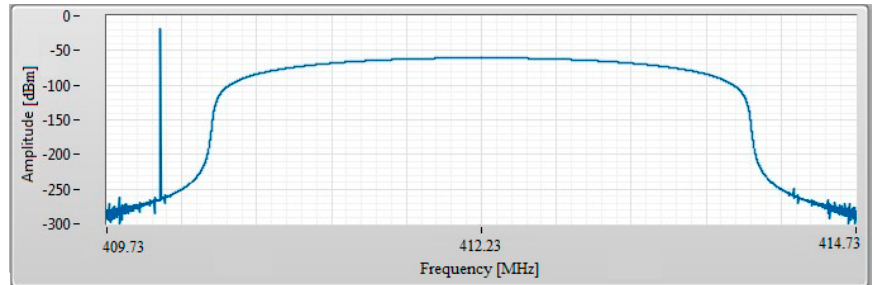
Figure 5. Transmitter architecture of the TRF antenna based on the USRP-2954R board.